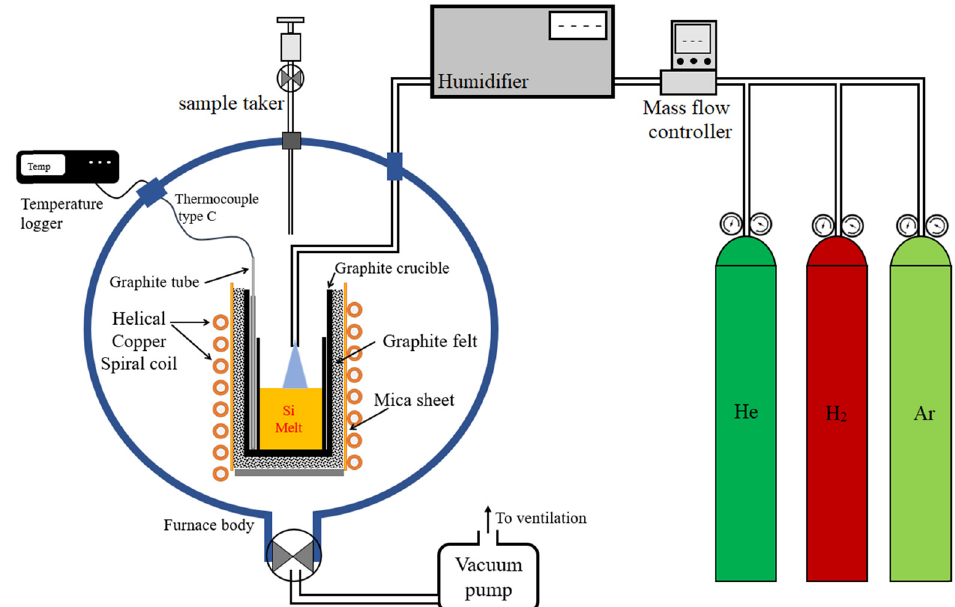
Figure 3: The schematic of the furnace and gas re fi ning set up.